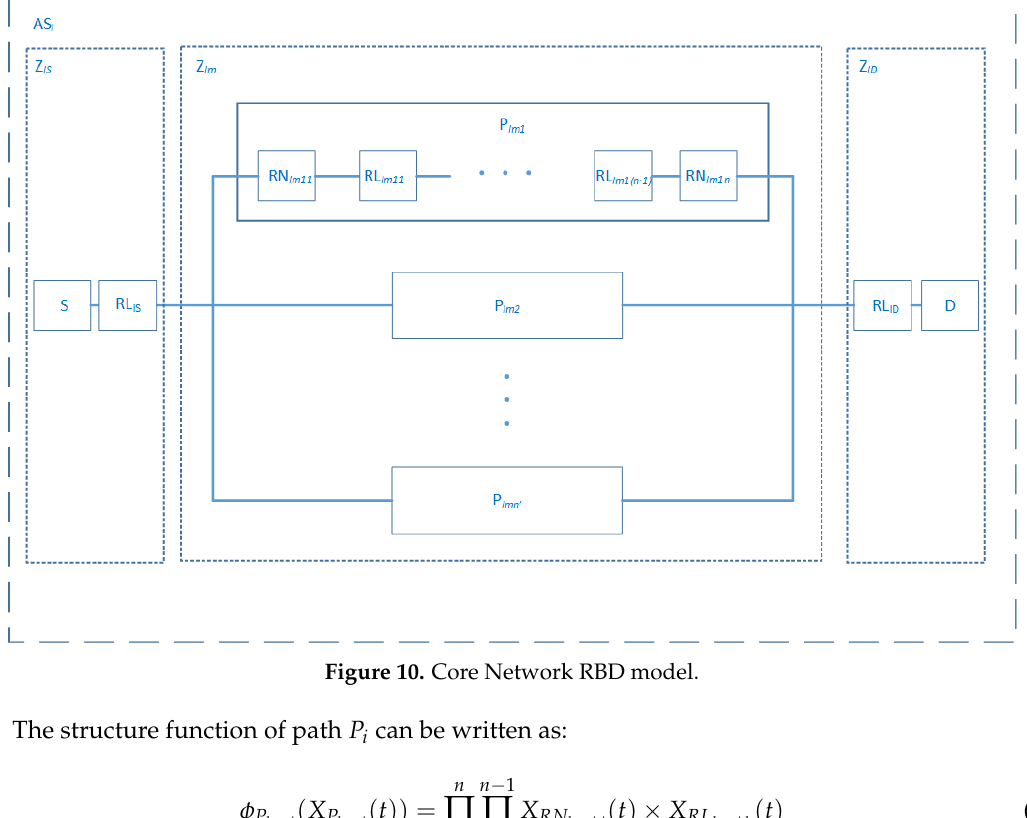
Figure 10. Core Network RBD